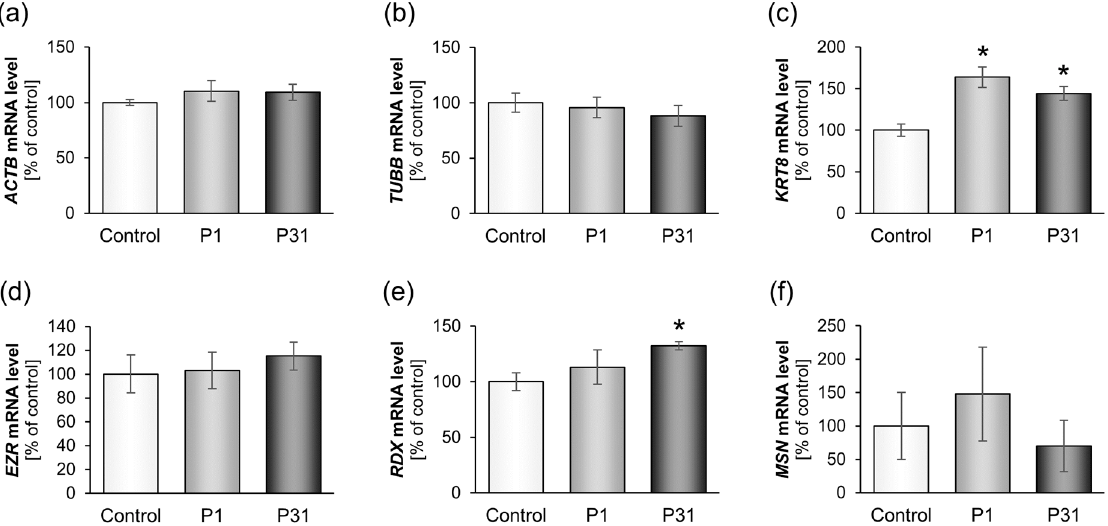
Figure 3. Influence of short-term microgravity on the gene expression (mRNA) of cytoskeletal factors. The data are given as mean ± standard deviation. * p < 0.05 vs. Control.